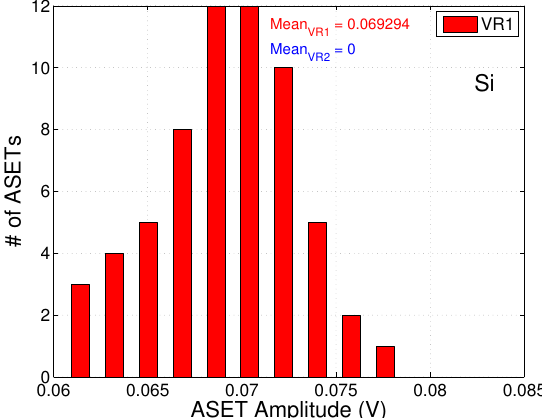
Figure 9. Measured number of ASETs versus ASETs peak amplitude for VR1 and VR2 circuits when exposed to